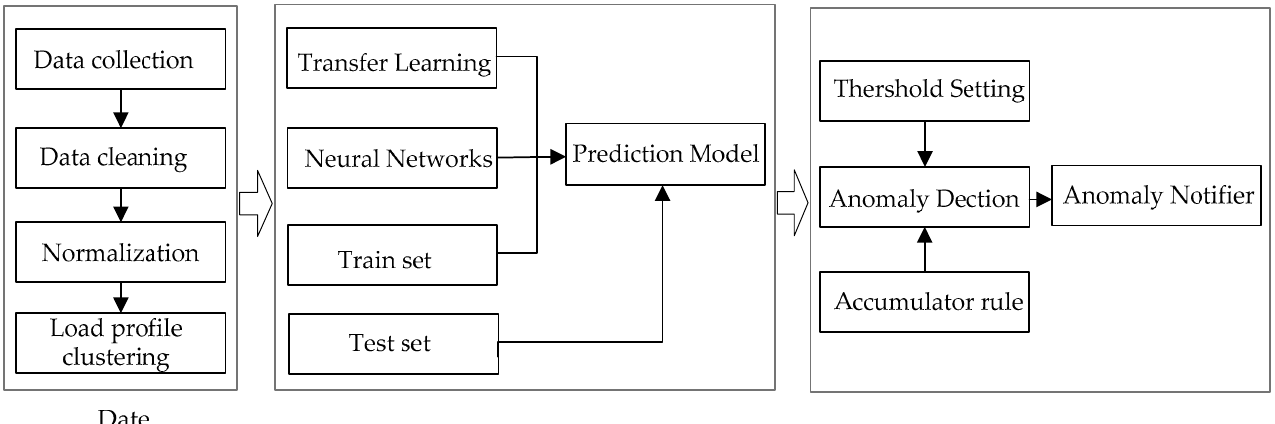
Figure 1. Workflow of malfunctioning smart meter detection.